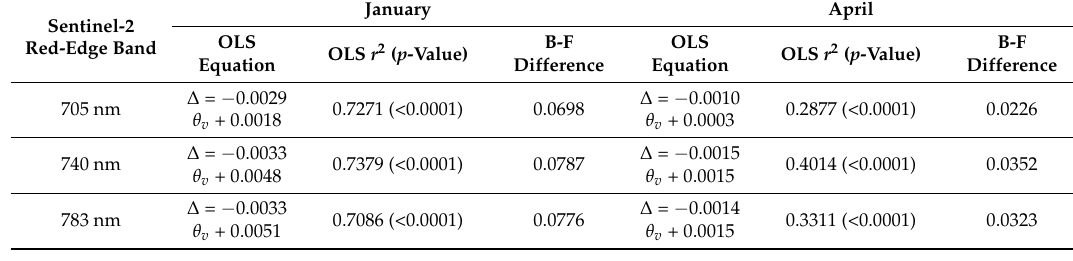
Table 4. Summary of the ordinary least squares (OLS) linear regressions of the surface reflectance differences illustrated in Figures 4 and 5; OLS regression coefficient of determination ( r 2 ), the OLS regression F-test p -value, and the B-F difference. A total of 6,600,685 and 10,656,197 pairs of forward and back scatter surface reflectance values were considered in January and April, respectively.